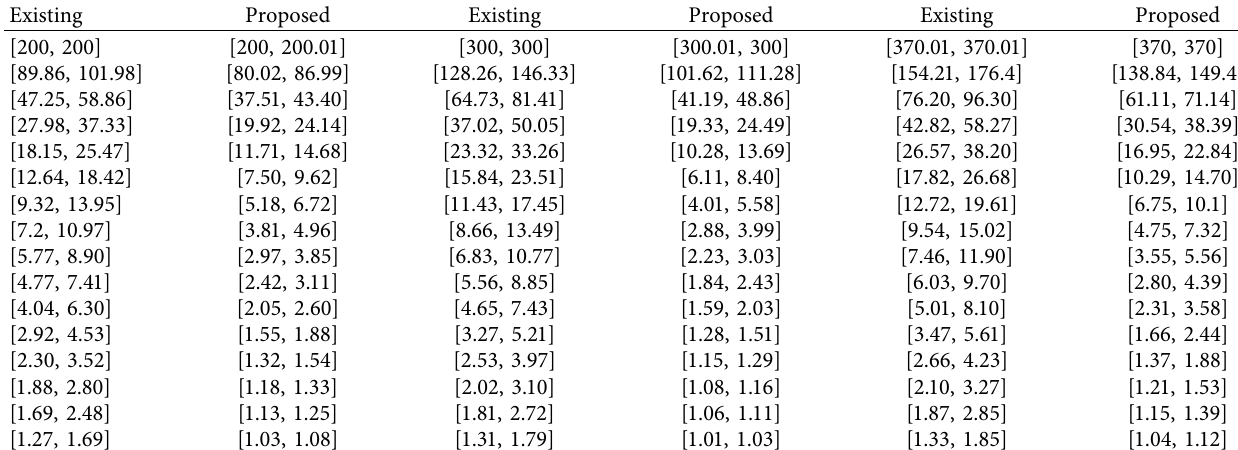
Figure 1: The proposed control for simulated data when a [ 1 . 5279 , 2 . 8818 ] . Table 3: Comparison of proposed control chart with neutrosophic Shewhart control chart. Existing Proposed Existing Proposed Existing Proposed [200, 200]